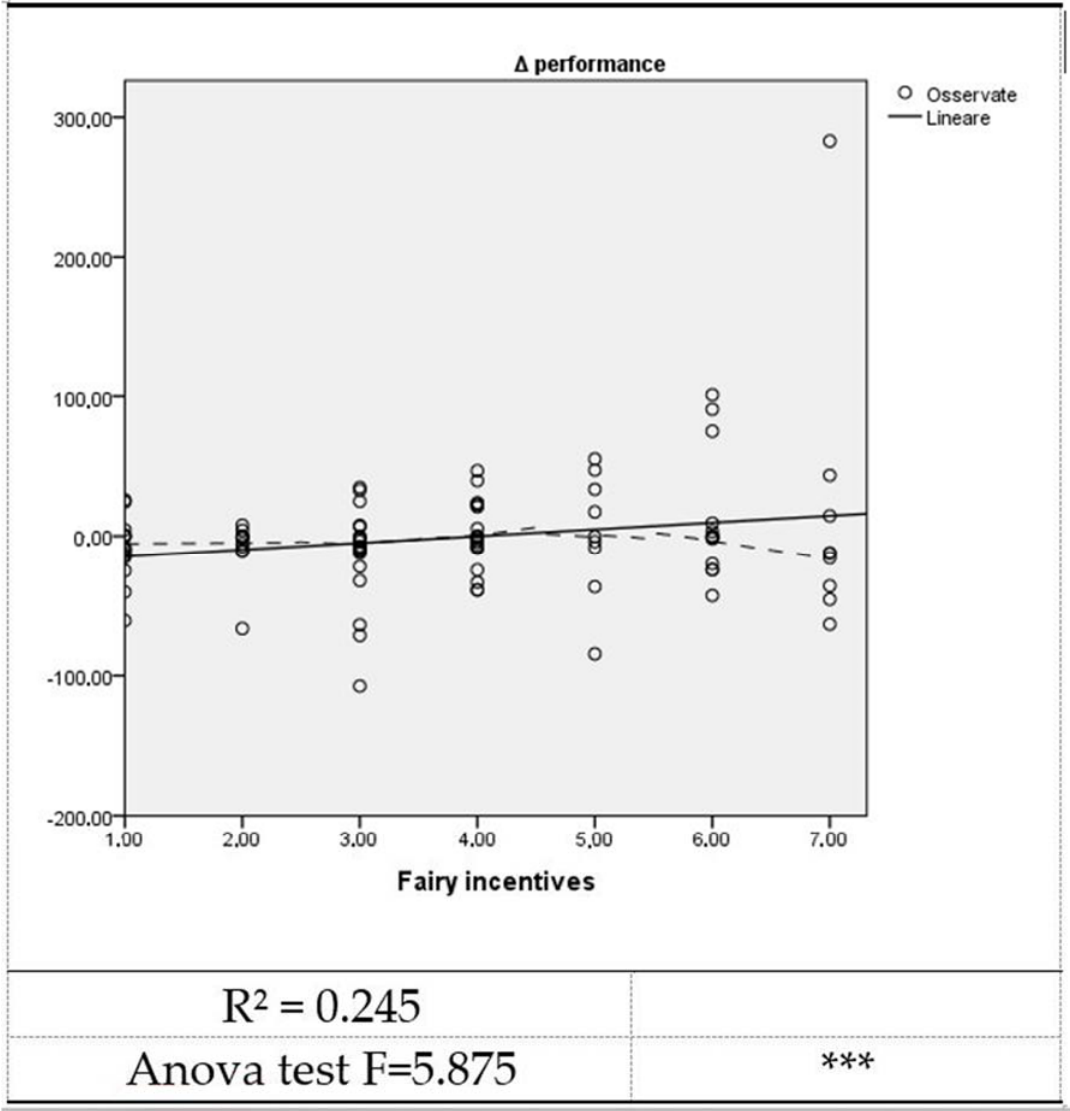
Figure 1. Estimated linear regression curve.